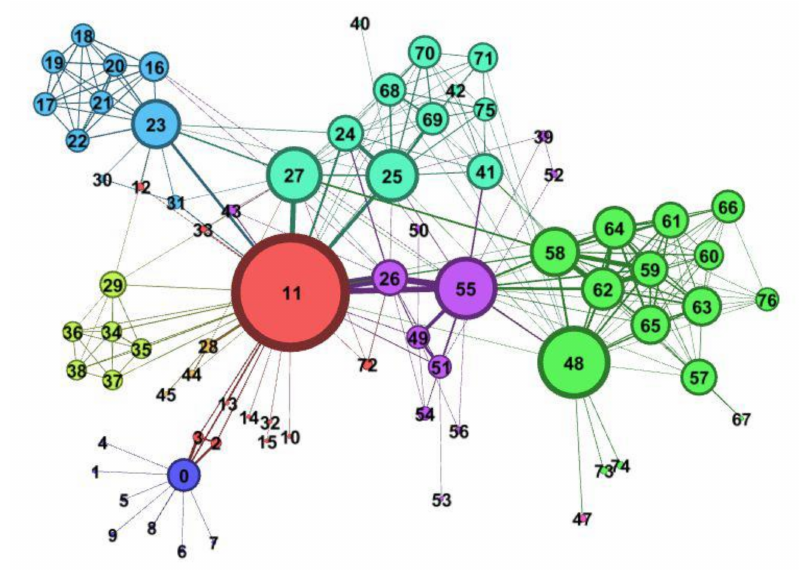
Figure 8. The topology of the C3DPS network.